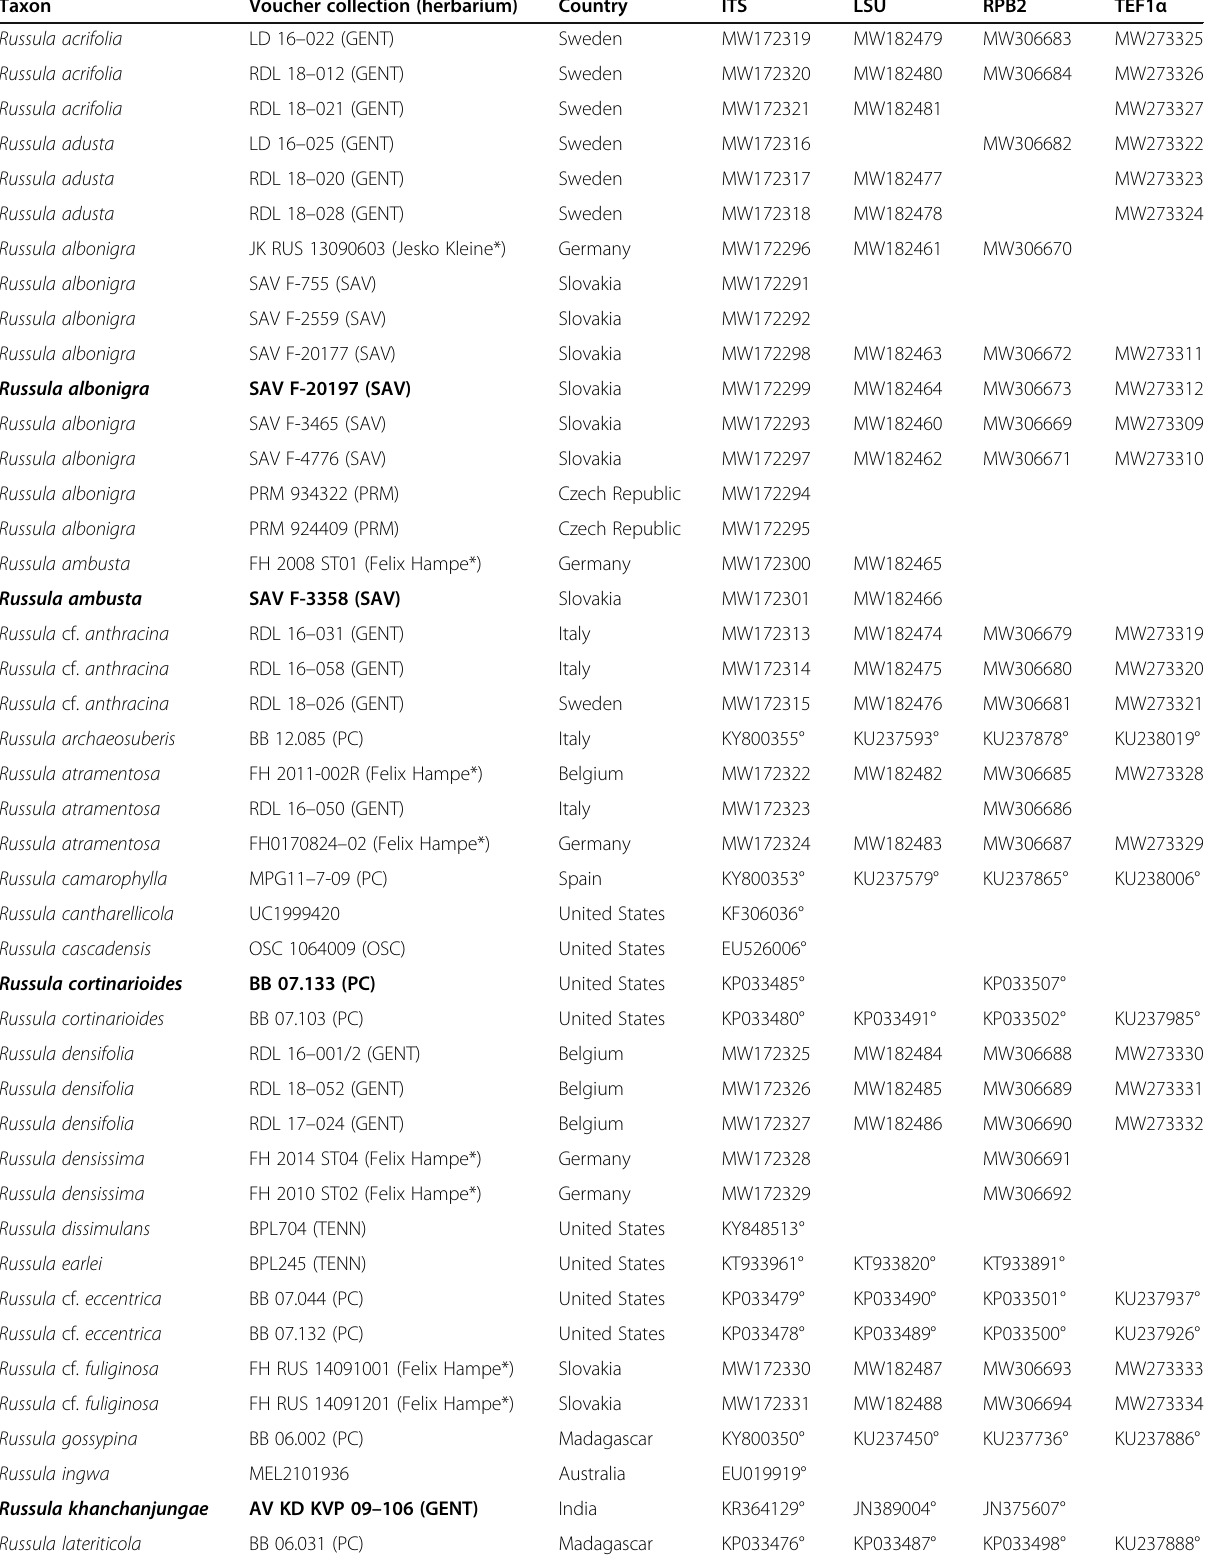
Table 1 Specimens and GenBank accession numbers of DNA sequences used in the multi-locus phylogenetic